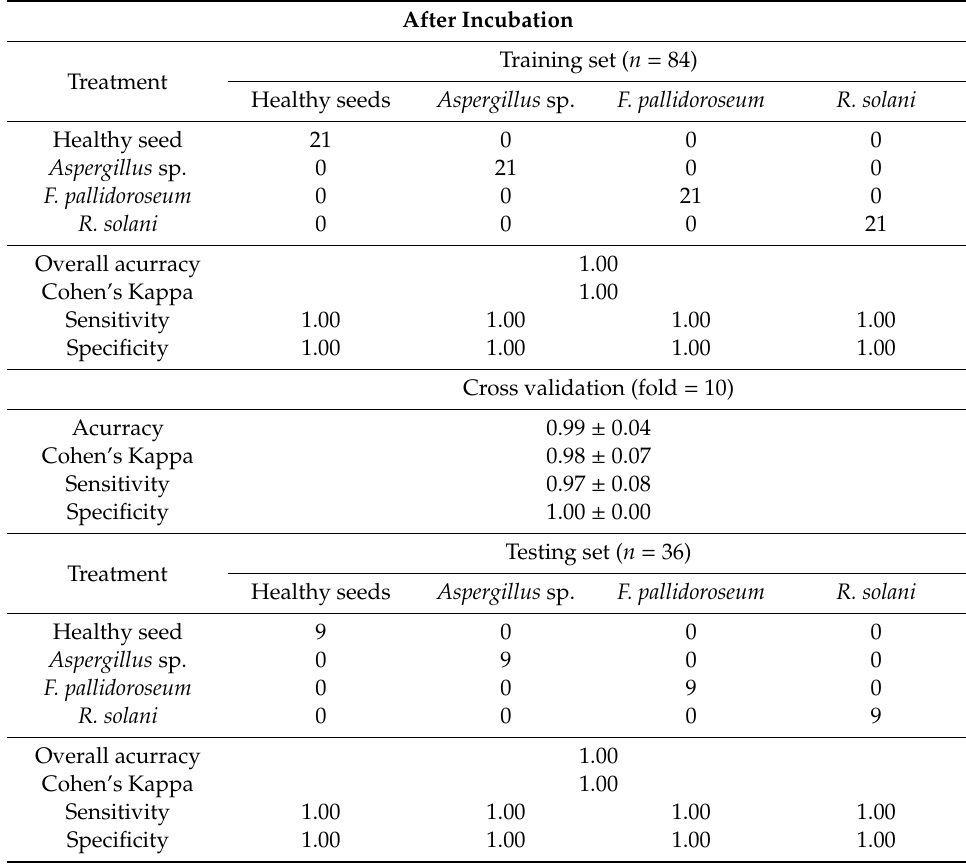
Table 2. Confusion matrices of the LDA model in training and testing set using reflectance, color and texture features of cowpea seeds at 19 wavelengths (365 to 970 nm) for class membership of healthy seed and incubated seed with Fusarium pallidoroseum, Rhizoctonia solani and Aspergillus